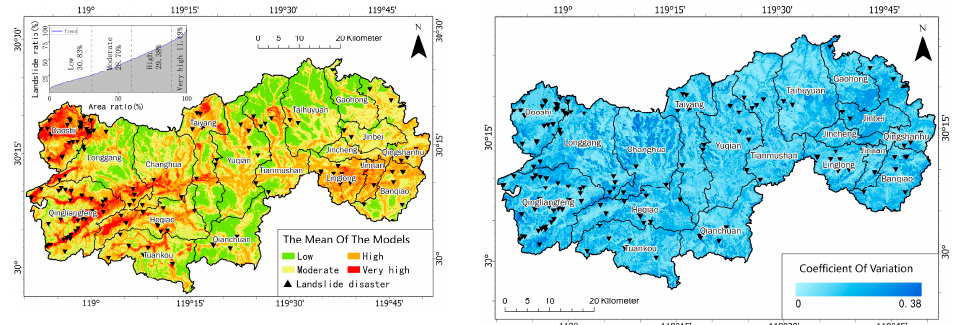
Figure 6. The mean landslide susceptibility levels ( left ) predicted by the four models and the coefficient of variance (CV; right ). Note: The black triangles are the inventory landslide points; the polygons are town boundaries.